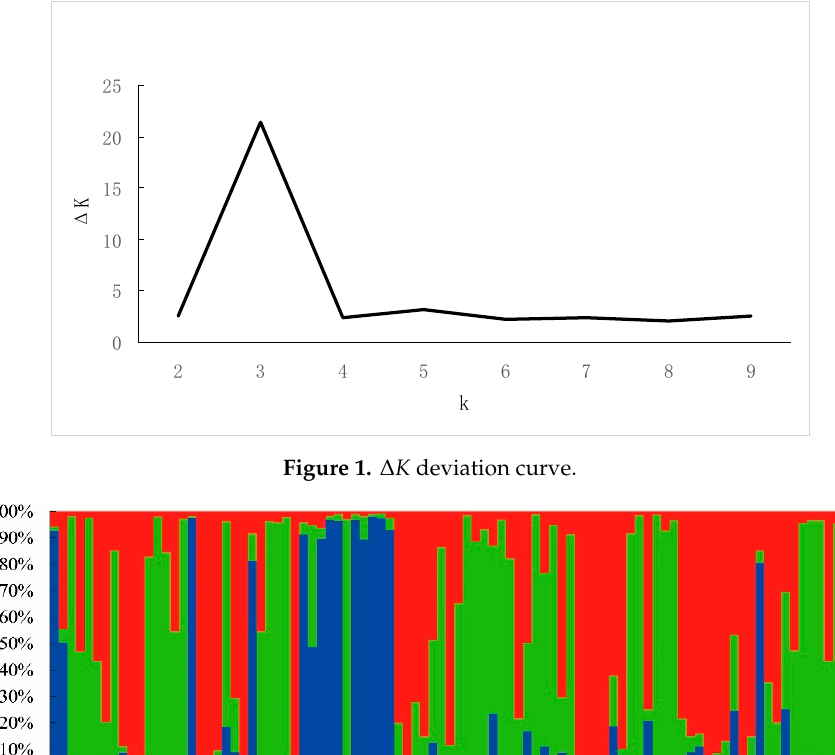
Figure 2. Bayesian genetic clustering of the 11 captive populations.